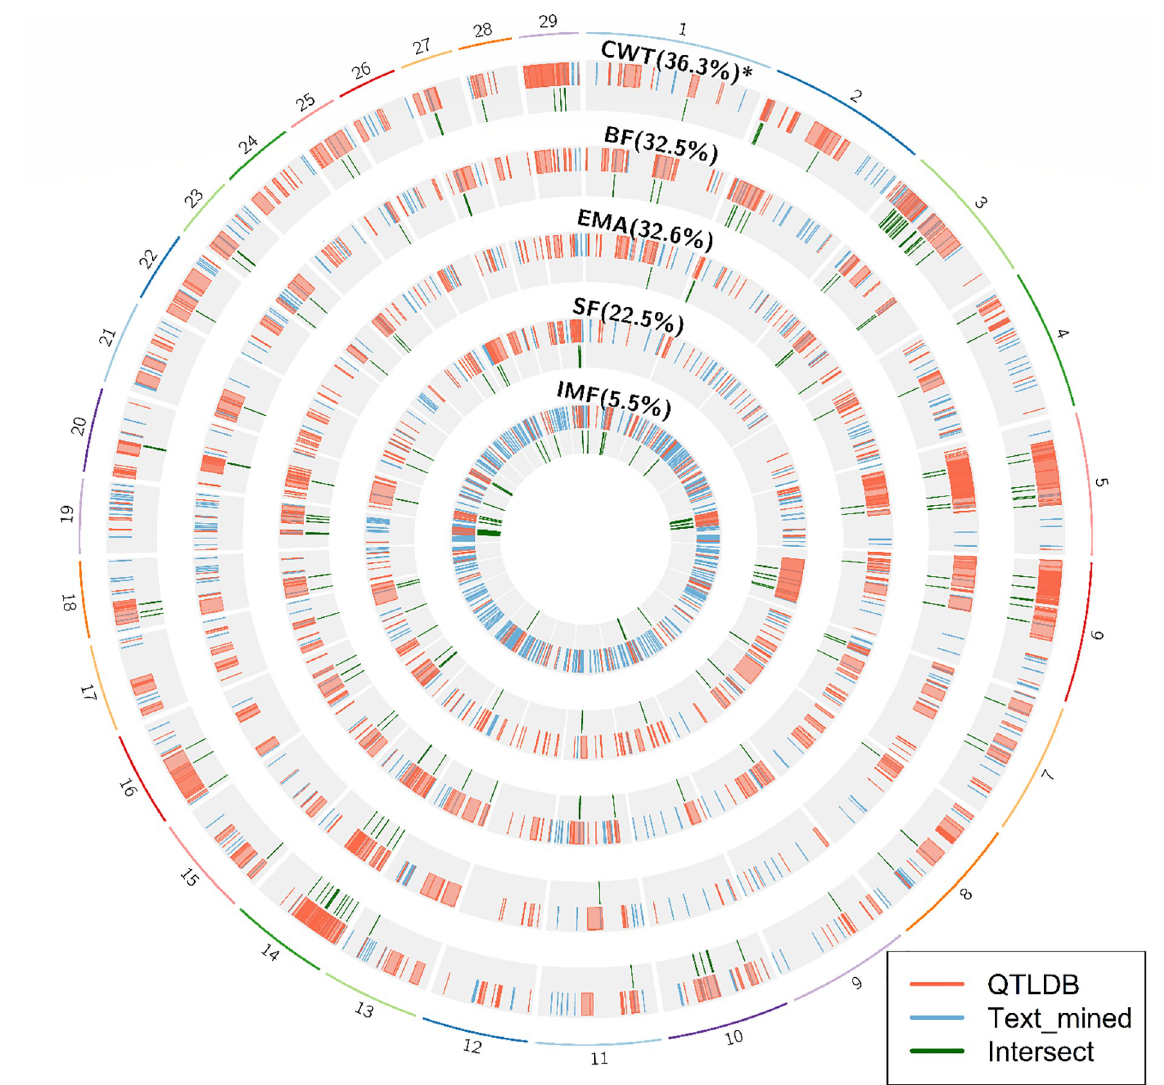
Fig 1. The karyotype of QTL regions registered in QTLDB, text-mined region, and the intersection of both regions. Each karyotype represents the region for the trait indicated above. Percentages in parentheses beside the trait names indicate the ratio of text-mined region within QTLDB